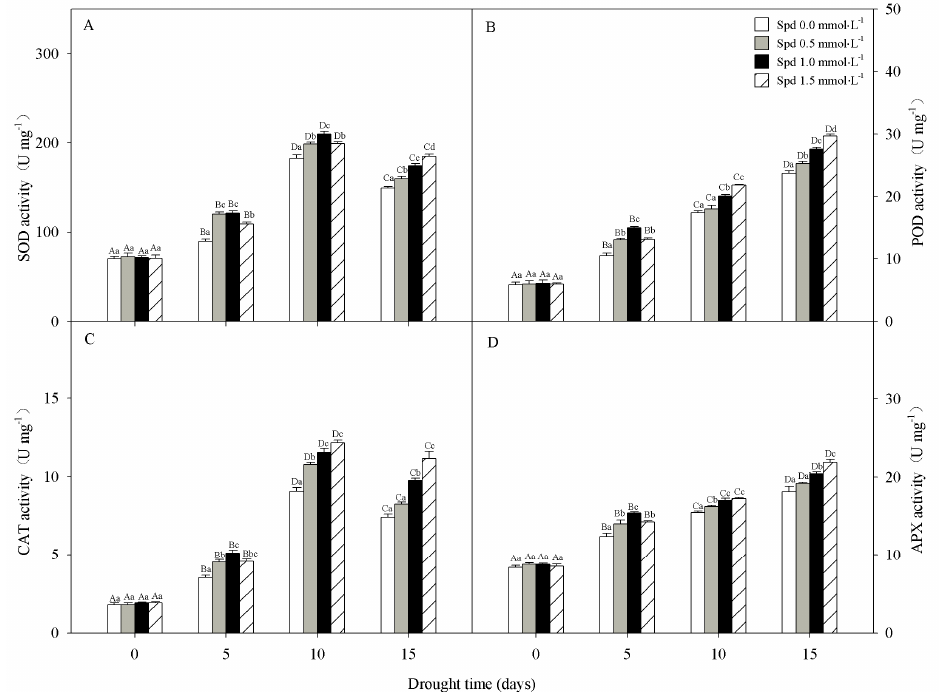
Figure 5. ( A ) Superoxide dismutase (SOD), ( B ) peroxidase (POD), ( C ) catalase (CAT), and ( D ) ascor- bate peroxidase (APX) activity of Hordeum jubatum shoots not Spd treated (S0) or pretreated with 0.5 mM Spd (S1), 1.0 mM Spd (S2), and 1.5 mM Spd (S3) under drought stress. Days 0, 5, 10, and 15 correspond to CK, D1, D2, and D3 in the experimental treatment, respectively. The capital letters denote significant differences among the different drought intensities from the shoots under the same concentrations of Spd. The small letters denote significant differences among the different concentrations of Spd from shoots under the same drought intensity. The differences in each parameter were tested by a one − way analysis of variance (ANOVA) at the p < 0.05 level. The bars represent the means ± SEs (n = 3).